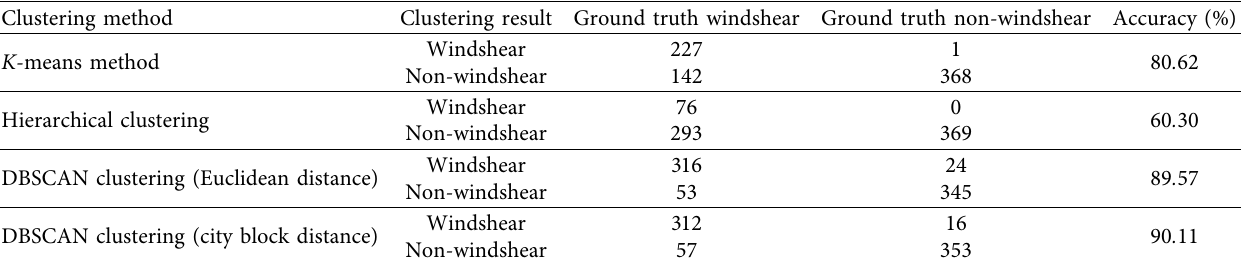
Table 4: Clustering results of diferent methods for feature vector proposed by Huang et